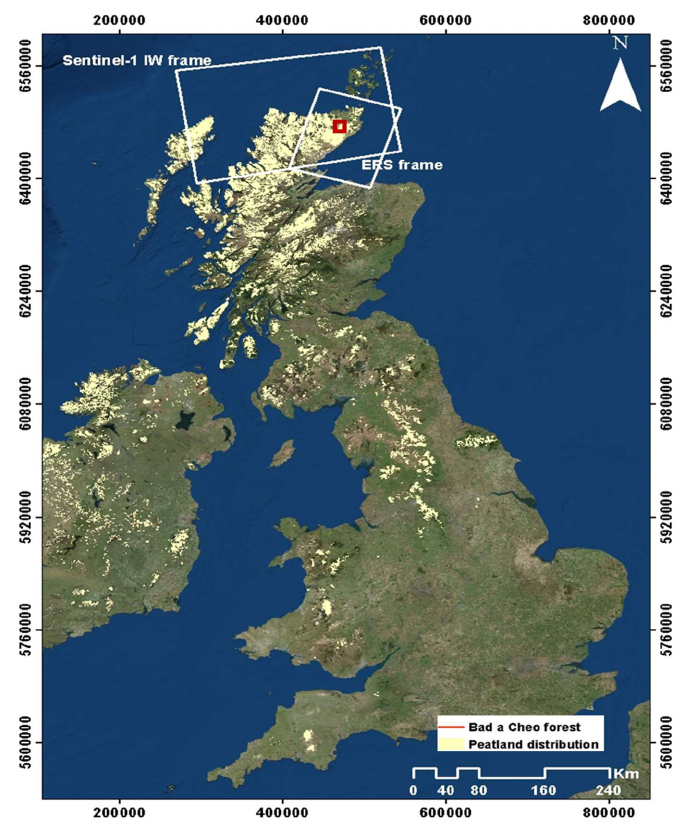
Figure 1. The distribution of blanket peat of the United Kingdom and Ireland, adapted from the 2012 CORINE (Co-ordinated Information on the Environment) along with the boundary of Bad a Cheo forest Reserve and the footprints of the ERS and Sentinel-1 SAR image frames. (WGS-1984-UTM-Zone-30N).